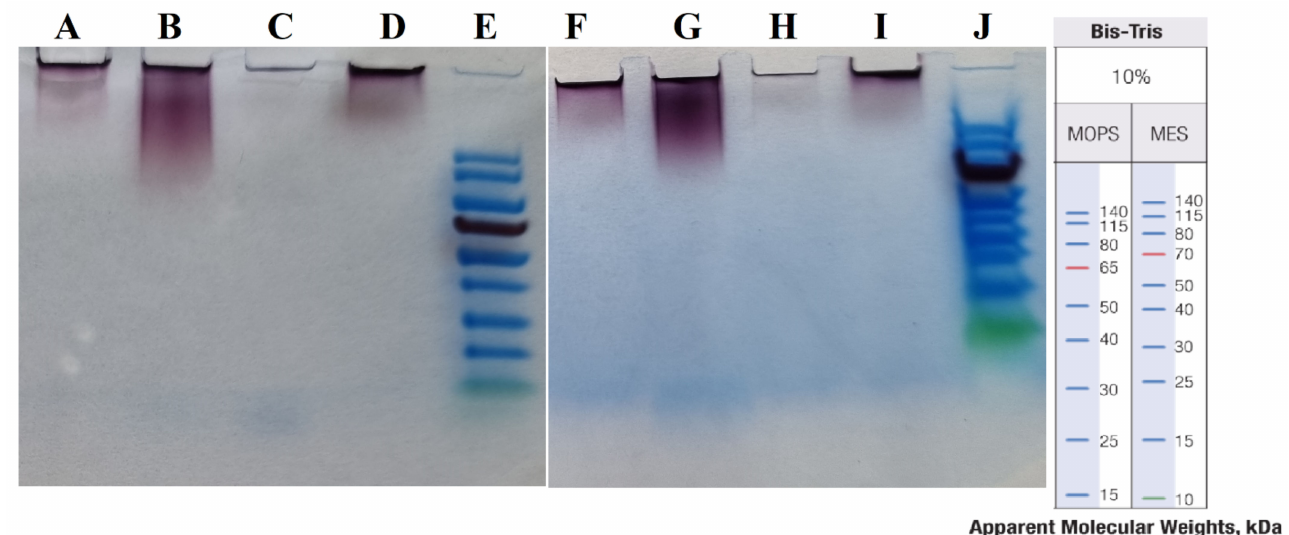
Figure 9. SDS-PAGE in two different buffers. ( A – E ) in MOPS and ( F – J ) in MES buffers. ( E , J ) are Thermo Scientific PageRuler Prestained Protein Ladders, with size shown on right. ( A , F ) “cold” AuNPs at 100 ◦ C, ( B , G ) “hot” AuNPs at 100 ◦ C, ( C , H ) “cold” AuNPs at 110 ◦ C, and ( D , I ) “hot” AuNPs at 110 ◦ C.